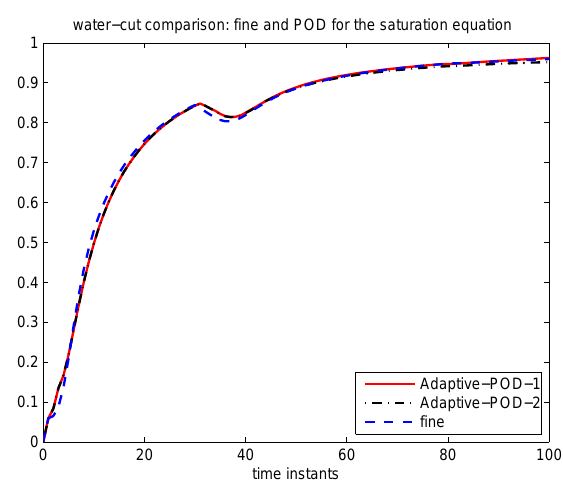
Figure 12. Water-cut of online adptive POD for the saturation equation.